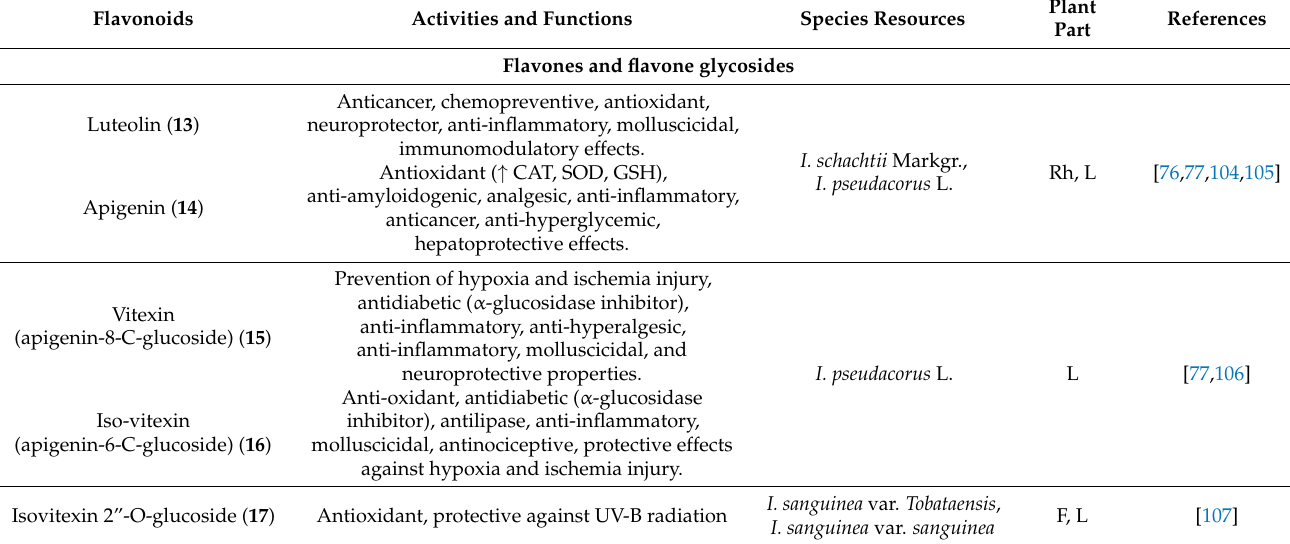
Table 4. Flavonoids present in Iris species and their antioxidant related